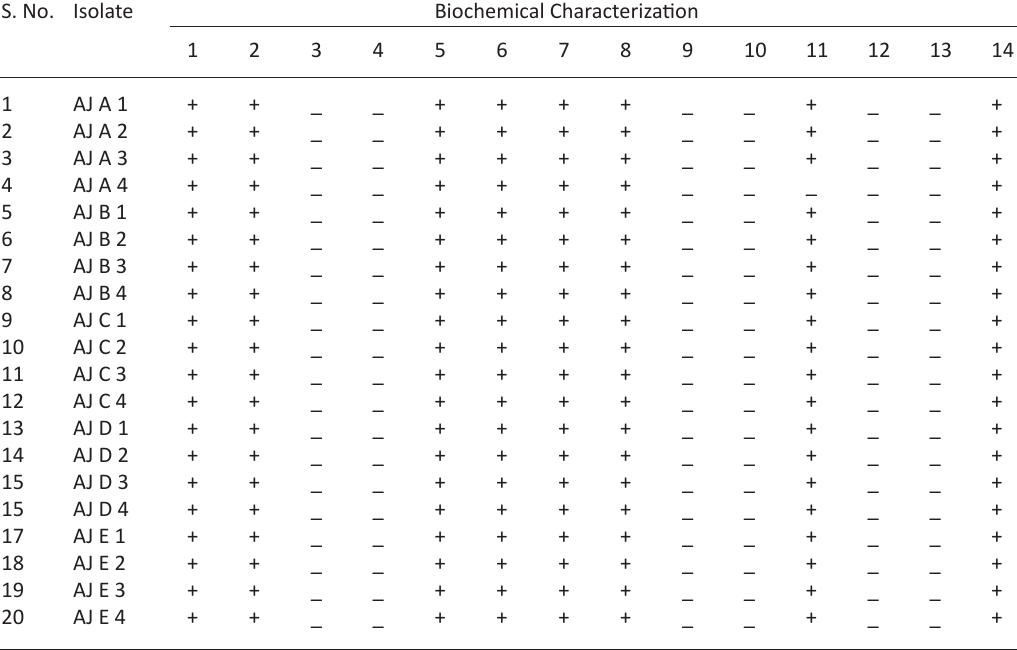
Table 3. Biochemical characterization of primary isolates S. No. Isolate